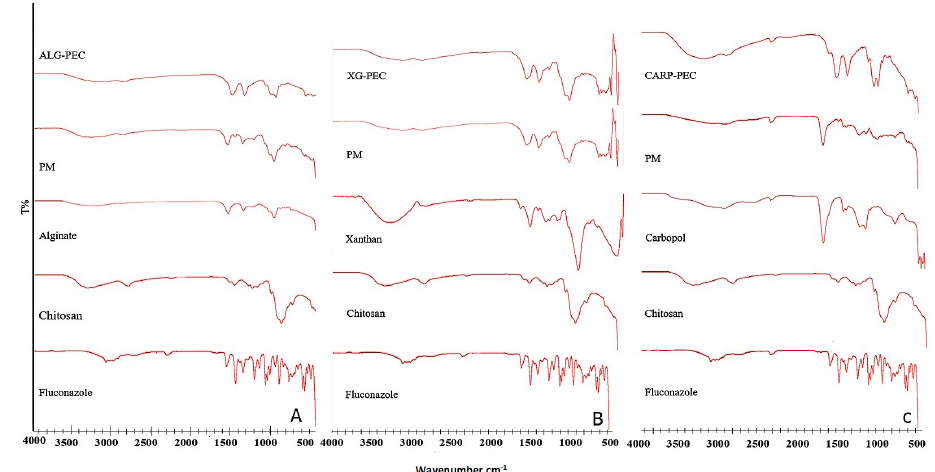
Figure 2. Fourier Transform Infrared (FTIR) spectra of fluconazole, chitosan, anion, their physical mixture (PM) and fluconazole CH/anion PEC ( A ) Na alginate (Alg) ( B ) Carpobol (Carp) ( C ) Xanthan gum (XG).